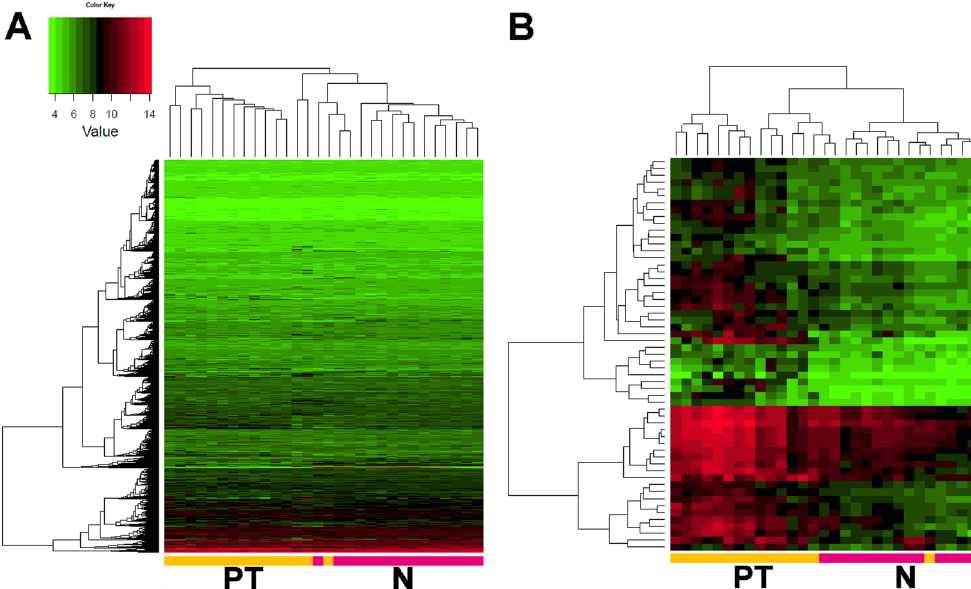
Figure 1. Gene set cluster analysis of 15 HNSCC samples and their 15 corresponding normal mucosa allows profiling of disease progression by identifying a condensed list of 38 most significant genes. Supervised two- way hierarchical clustering and gene tree representation adjusted to the primary site of all genes (A) and differentially regulated genes (B) allow separating primary tumours and normal mucosa. X-axis’ represent patient samples; y-axis’ represent the list of probe sets grouped by similarity using Pearson correlation. Intensities recorded for genes are colour coded: Green – low expression, Red – high expression, Black – medium expression. Orange bar: primary tumour samples; pink bar: normal mucosa samples. ( A ) Heatmap of all probesets shows the comparison of primary tumours and normal tissue mucosa (PT vs .N). ( B ) Stringent filter criteria (log 2 FC ≥ 1.5 and p-value < 0.0001, corresponding to a FDR of 0.003) were used to reduce the probesets to the most significant for PT vs .N, leading to a condensed list of 38 genes able to distinguish diseased from non- malignant tissue. Signature genes are listed separately in Table